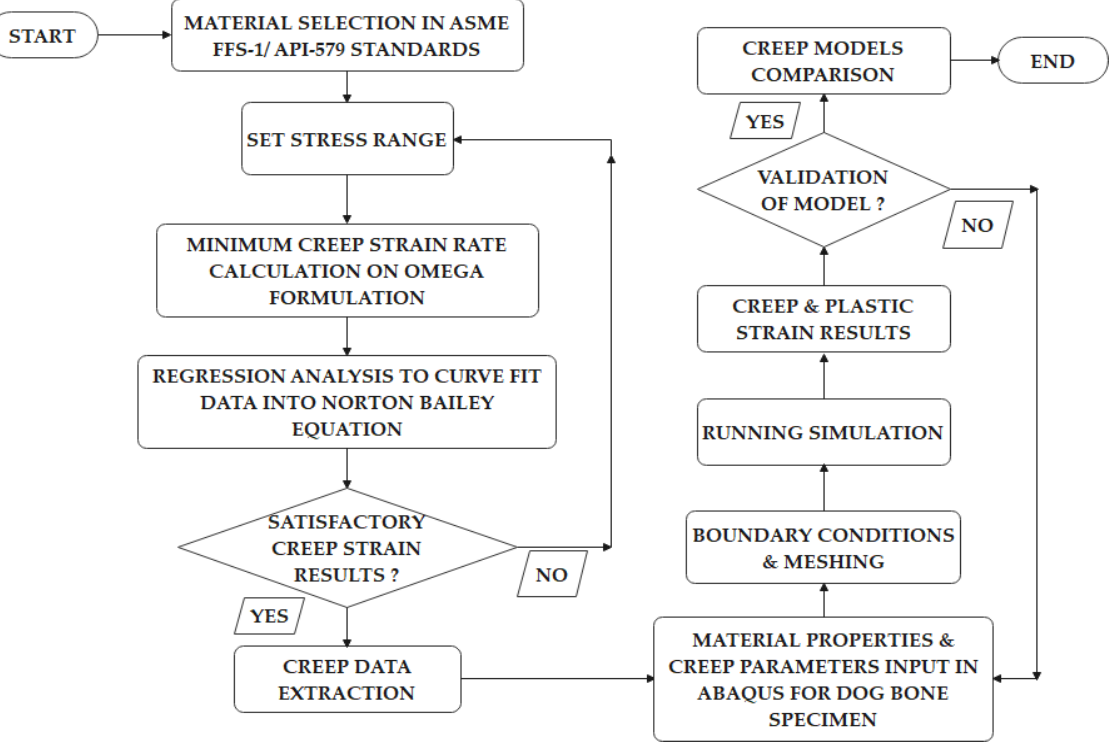
Figure 1. The overall process flow of the methodology to obtain creep data based on the Omega-Norton–Bailey regression model for the Abaqus dog bone